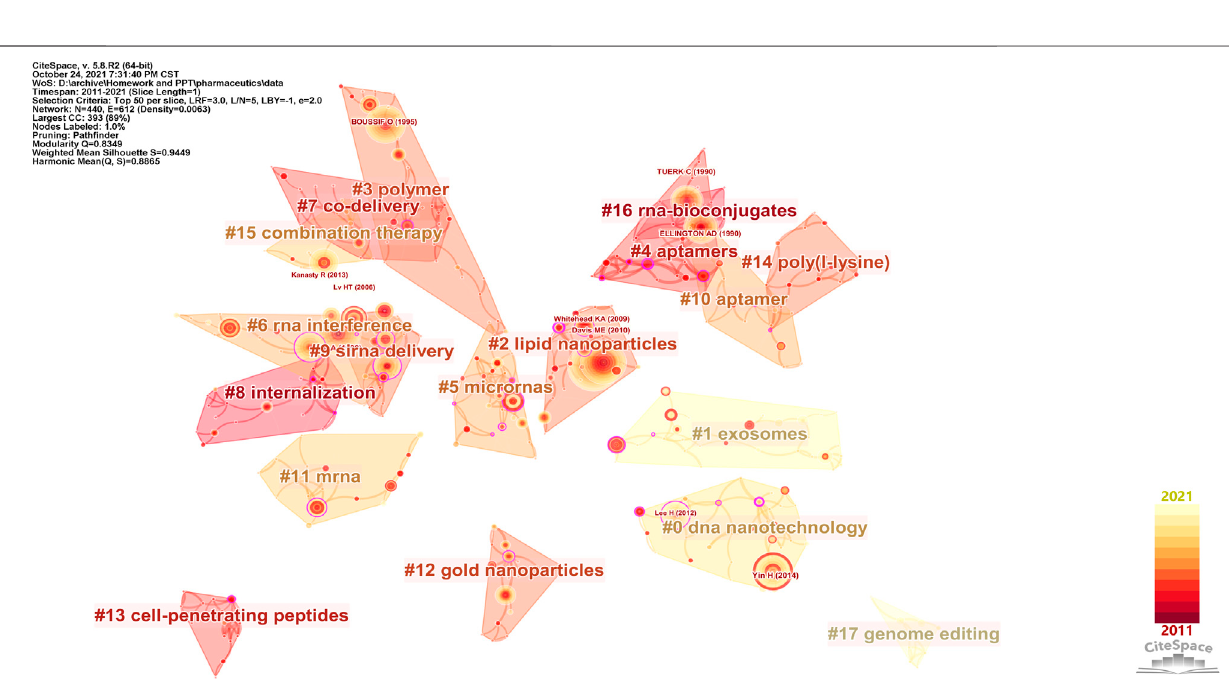
Frontiers in Pharmacology |